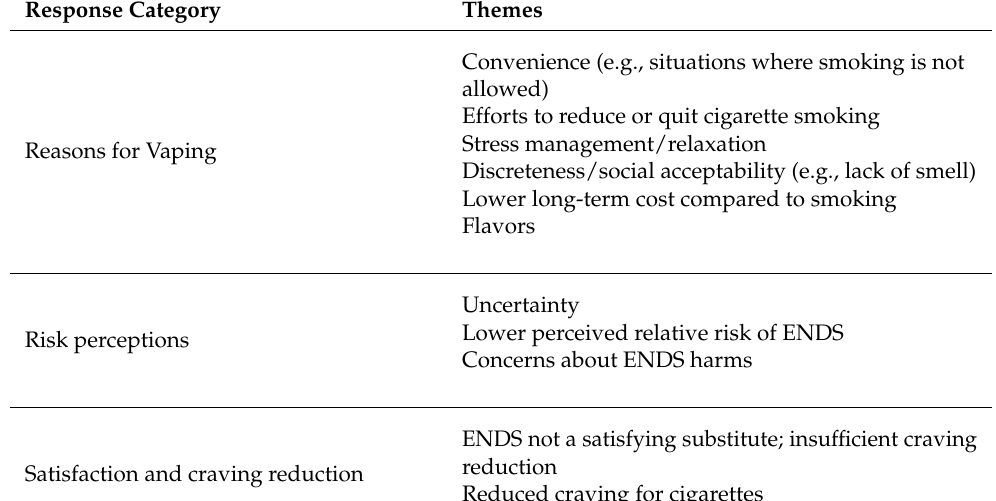
Table 2. Response Categories and Themes from Qualitative